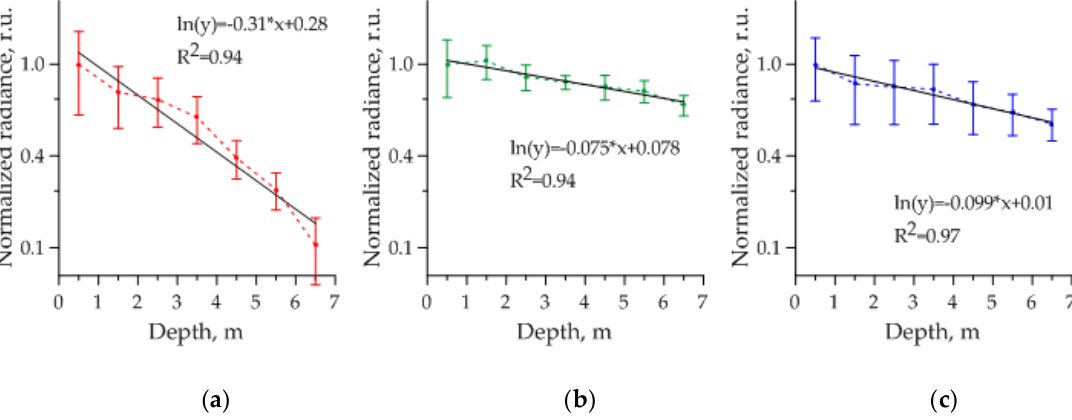
Figure 8. The recovery results of the absorption coefficient by 150 frames of each color filter as a function of seven depths: ( a ) 420 nm, ( b ) 530 nm and ( c ) 650 nm. Y-axis utilizes the scale of the natural logarithm.